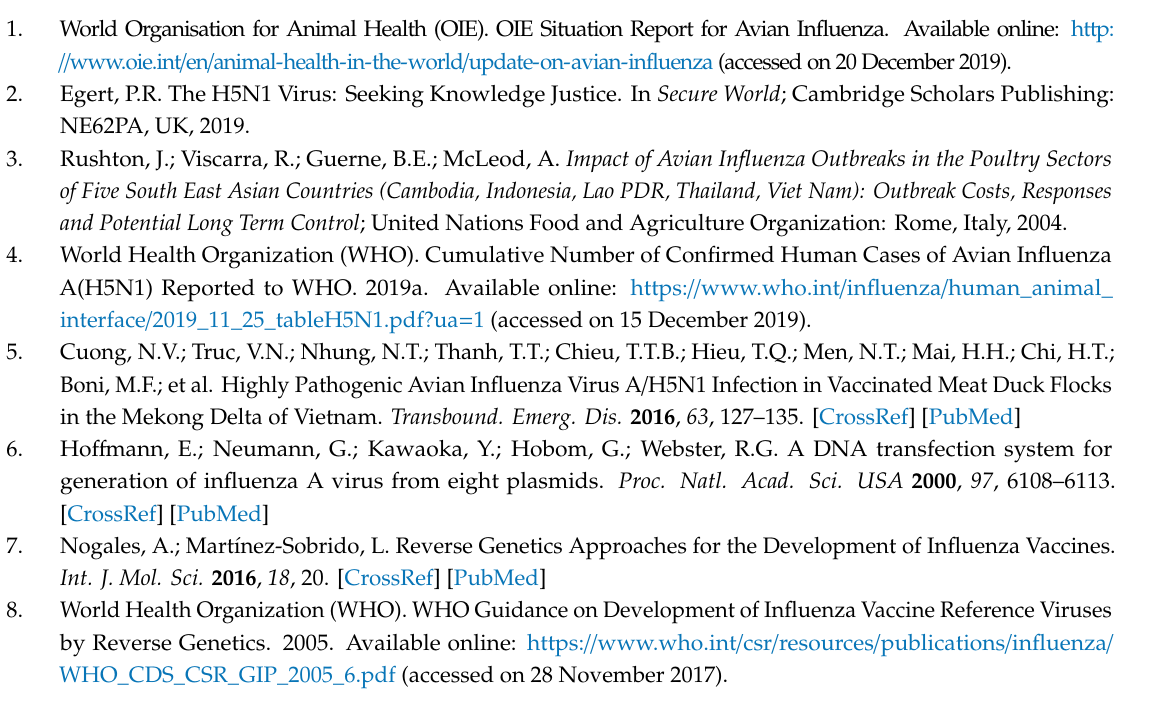
Figure S1. Stability of the artificial HA gene from the rescued virus was validated by sequencing. Table S1. Safety analysis of the rescued recombinant H5N1 virus in immunized